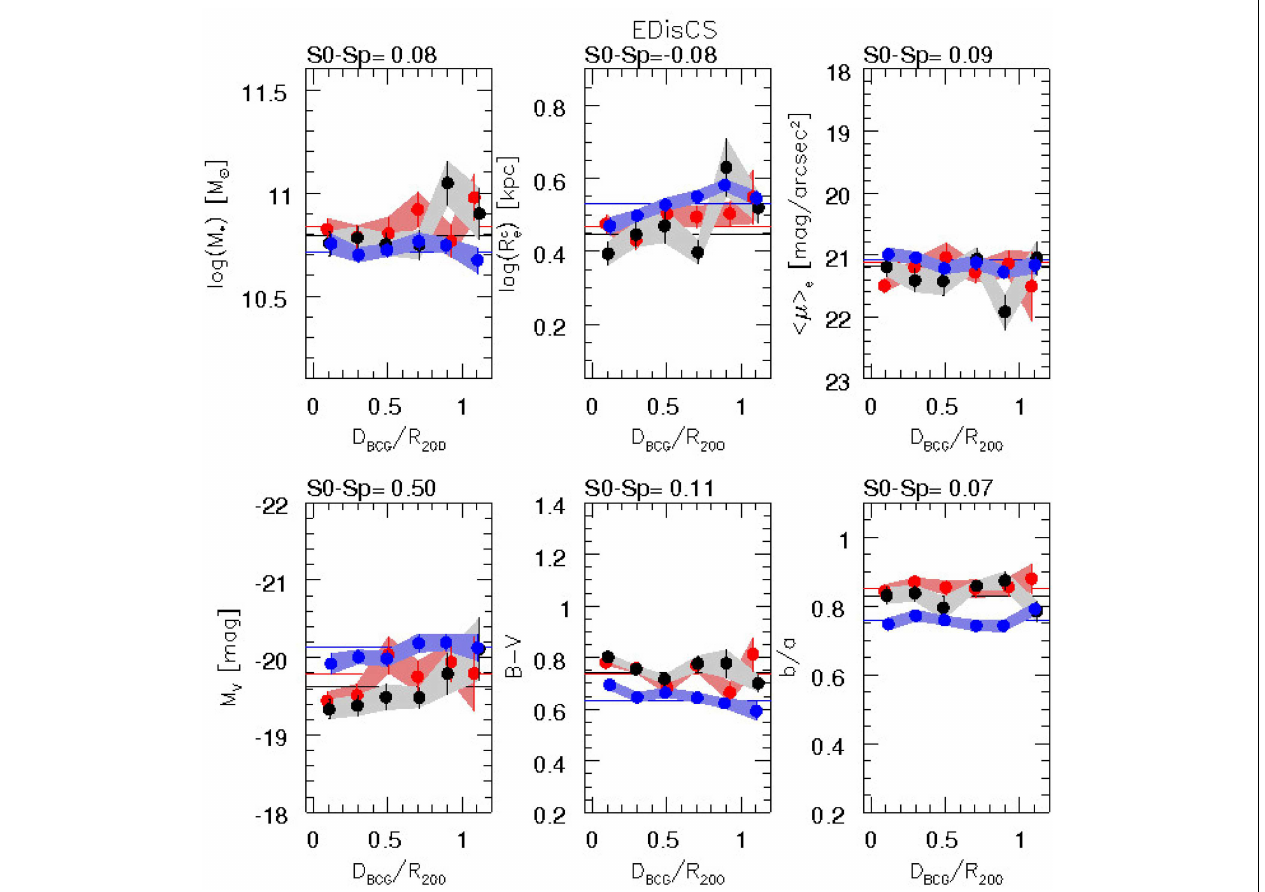
FIGURE 10 | The trend of the measured parameters for the EDisCS sample as a function of the cluster-centric